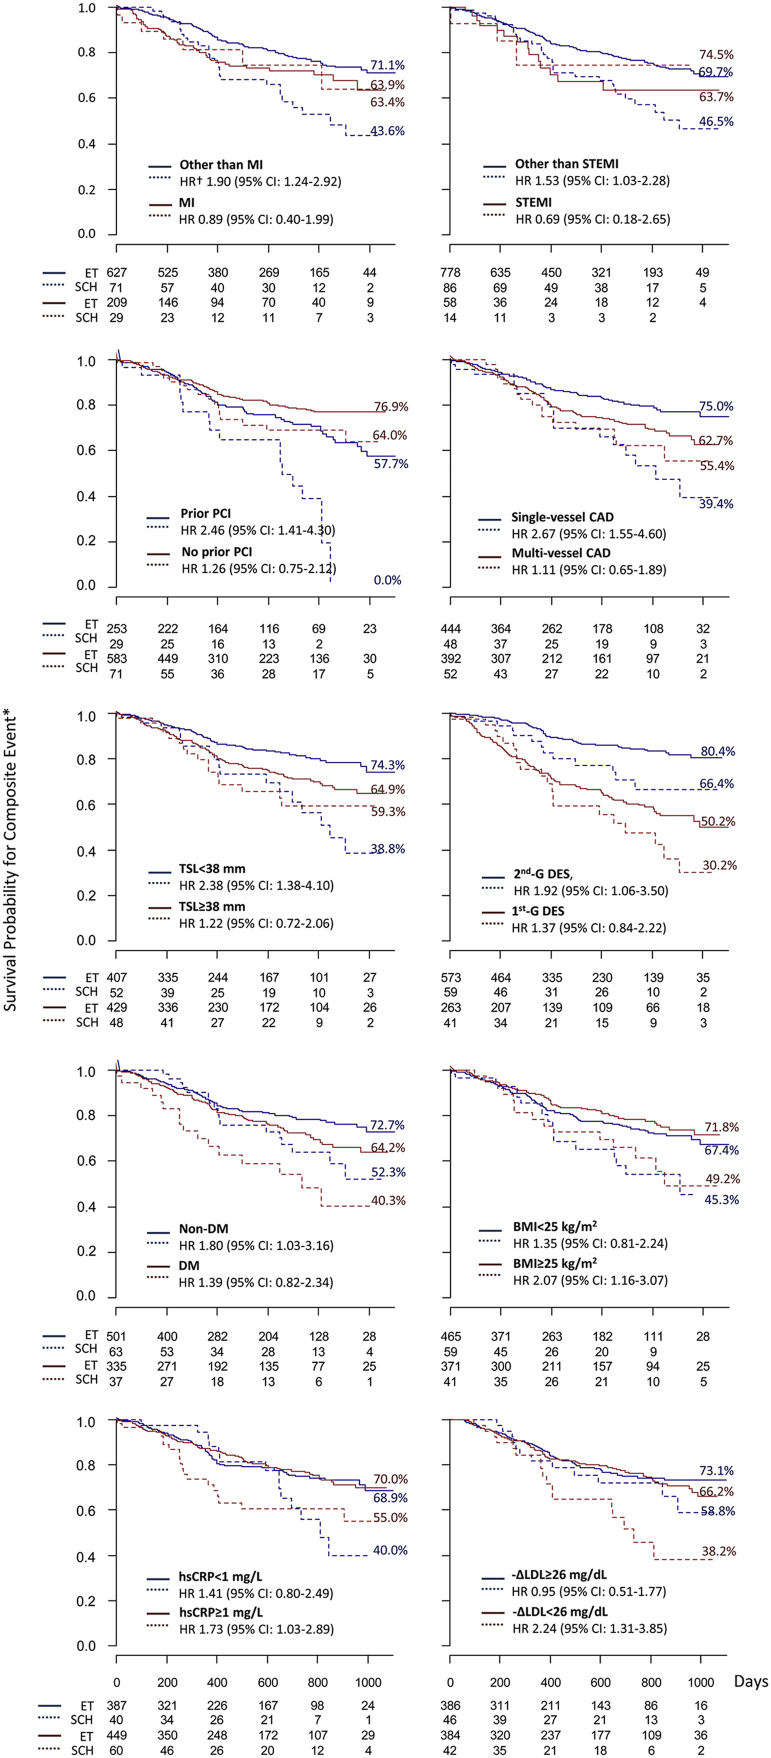
The influence of SCH on the composite event occurrence following PCI in various subgroups.The continuous lines represent the survival estimates in the ET group and the broken lines represent those in the SCH group. The numbers with percentages indicate Kaplan-Meier survival rates at 1000 days of observation. SCH was significantly associated with the composite event in patients with a diagnosis other than MI/STEMI, prior PCI, single-vessel CAD, TSL <38 mm, 2nd-G DES implantation, diabetes mellitus, BMI ≥25 kg/m2, hsCRP ≥1.0 mg/l, and -ΔLDL <26 mg/dl.*The composite event is a combination of cardiac death, non-fatal MI and repeat revascularization.†Adjusted for relevant covariates.HR, Hazard ratio; CI, Confidence interval; SCH, subclinical hypothyroidism; ET, euthyroidism; MI, myocardial infarction; STEMI, ST-segment elevation MI; PCI, percutaneous coronary intervention; TSL, total stent length; 2nd-G, Second generation; 1st-G, First generation; DES, Drug-eluting stent; CAD, coronary artery disease; DM, diabetes mellitus; BMI, body mass index; -ΔLDL, low density lipoprotein cholesterol reduction; hsCRP, highly sensitive C-reactive protein.